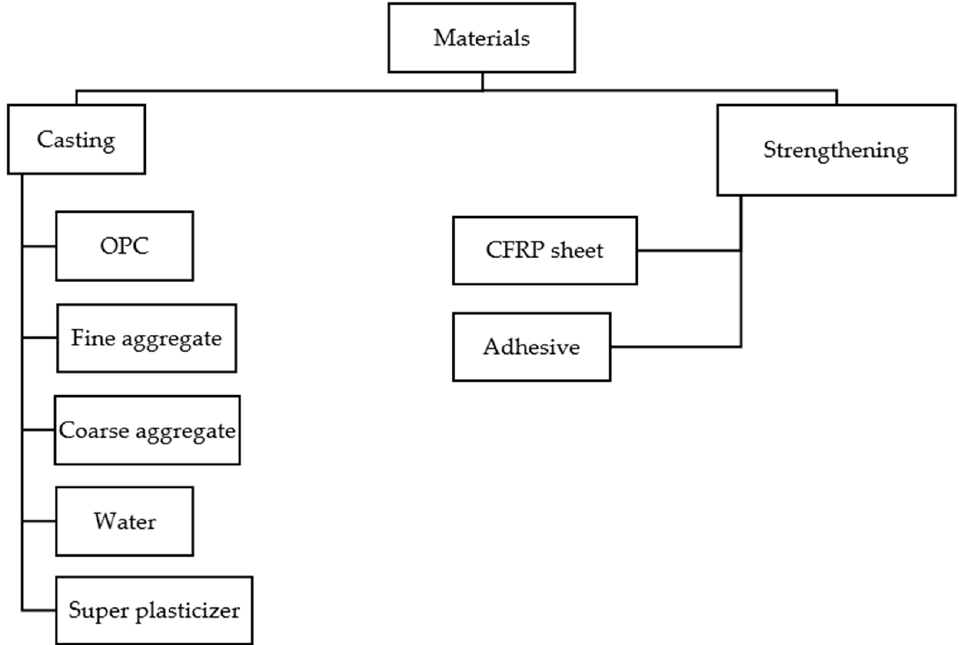
Figure 4. Material used for casting of beams.